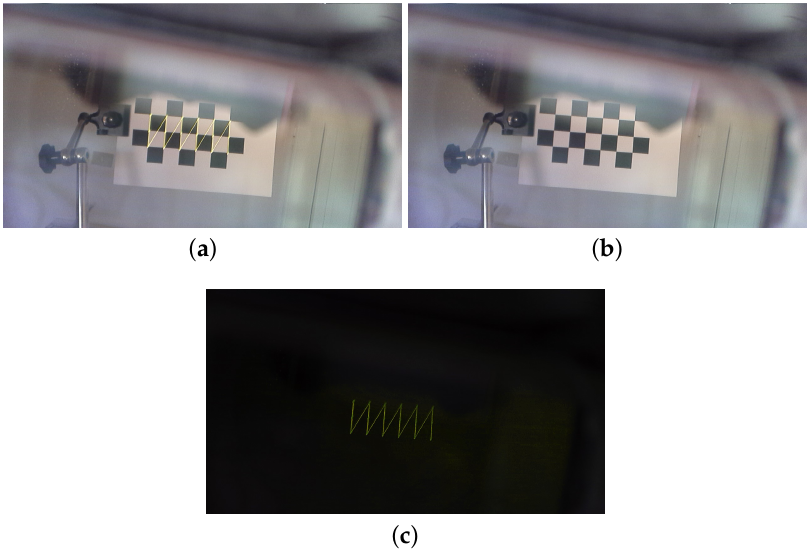
Figure 9. Viewpoint camera frames. ( a ) Camera frame of the augmented scene. ( b ) Camera frame of the real-world scene. ( c ) Camera frame of the virtual scene. Table 1. Results of the accuracy analysis in pixels (overlay error), arcmin (angular error), and mm (absolute error). Overlay Error Angular Error Absolute Error Camera (pixel) (arcmin) (mm) Position Mean Std Dev Max Mean Std